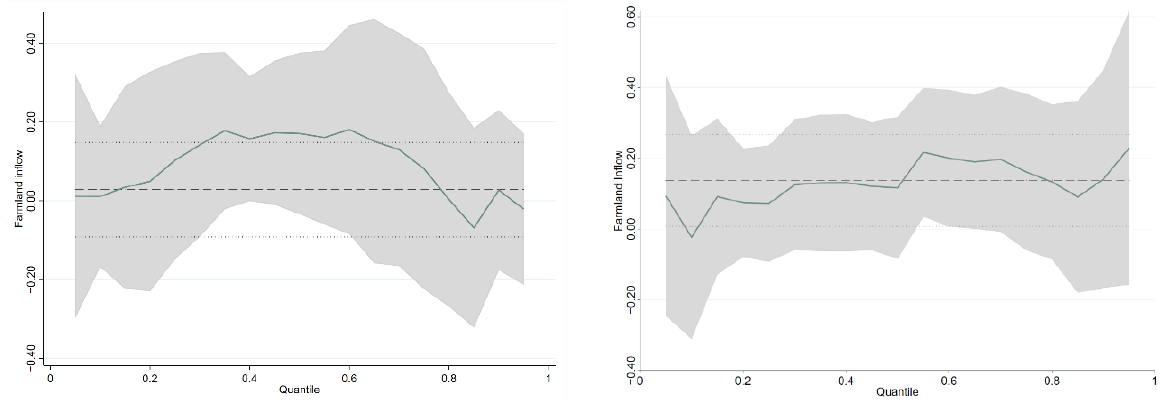
Figure 1. The fitting curve of farmland transfer on current investment ( left ) and fixed investment ( right ).